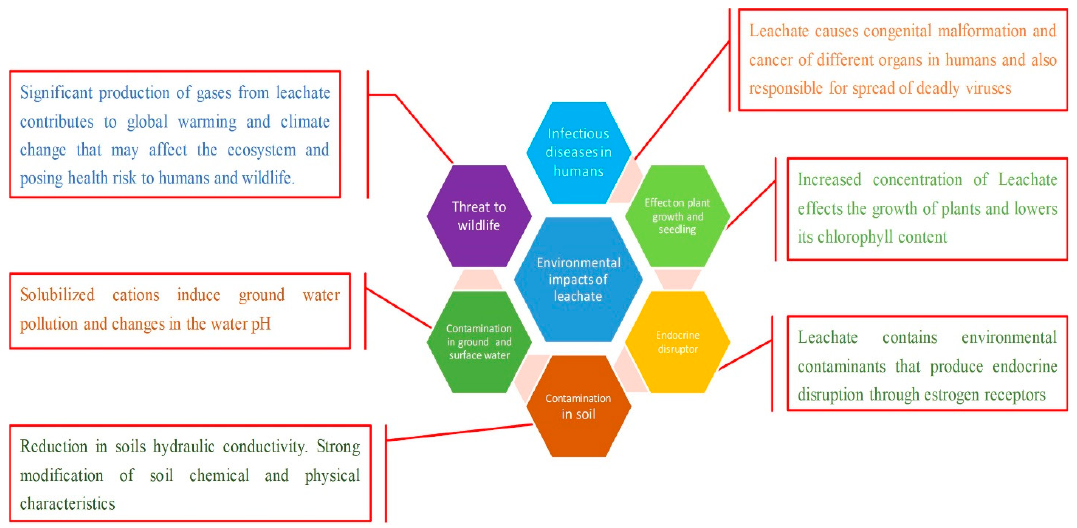
Figure 2. Impacts of leachate on human health and the environment.